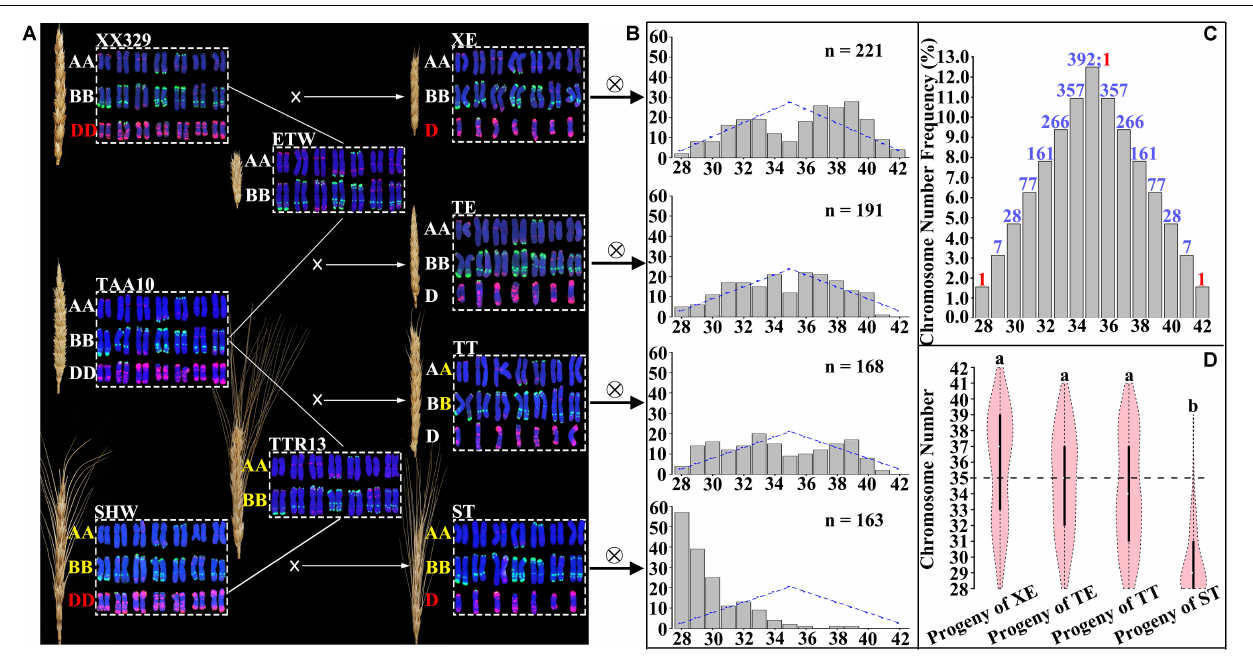
FIGURE 1 | Four different pentaploid wheat lines generated by crossing three hexaploid wheat genotypes with two tetraploid wheat genotypes, and the overall chromosome number distributions in the immediate progeny swarms of the pentaploids. (A) FISH-based karyotypes and spike morphology of hexaploid wheat, tetraploid wheat and pentaploid wheat. PSc119.2 (green coloration) and pAs1 (red coloration) were used as FISH probes. Subgenome designations (A,B,D) in the same and different colored fonts denote that they were from the same source or difference sources. (B) Theoretically expected (blue lines) and observed (gray bar) plant numbers in each of the immediate progenies of the four pentaploid wheat lines. Expected values were obtained by transforming the total karyotyped plant number according to the expected frequency in (C) . The numbers of observed (karyotyped) individuals in each F2 population are given. The x-axis is the chromosome number. (C) Theoretical (expected) chromosome number distribution in the immediate progeny swarms of pentaploid wheat. The numbers on the top of the gray bars refer to the expected values in each of the chromosome number categories belonging to either aneuploidy (colored blue) or euploidy (colored